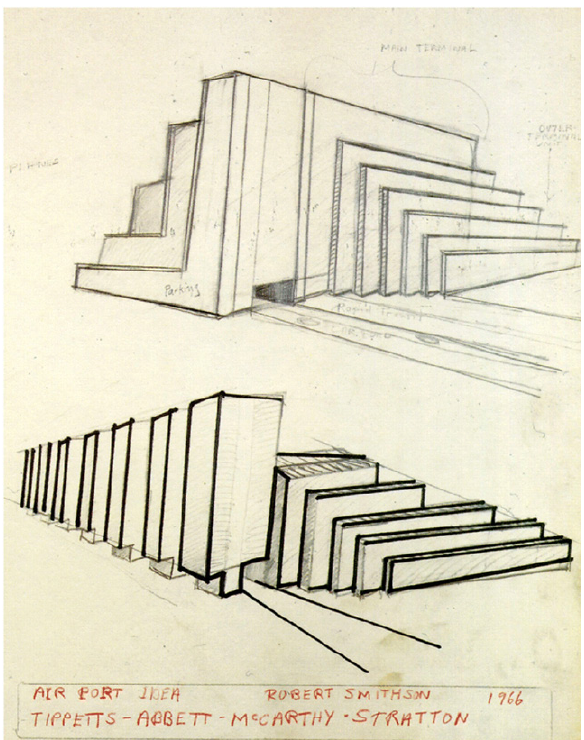
Figure 10. Robert Smithson, Airport Idea,